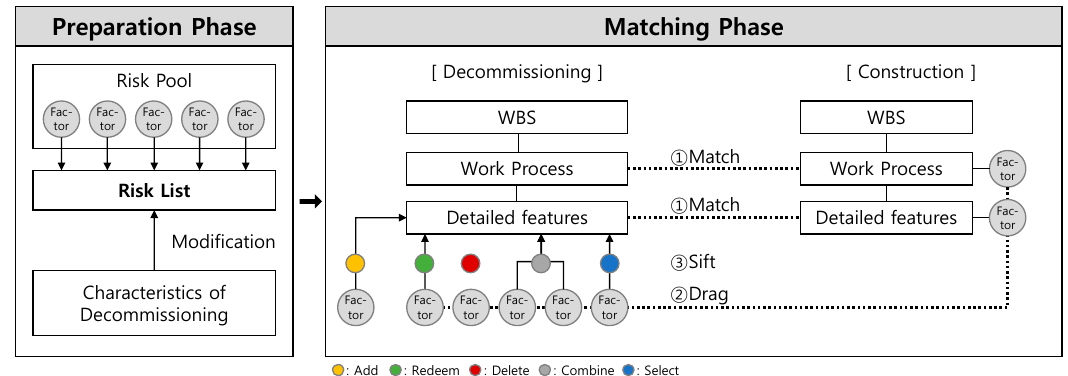
Figure 1. Flow of research methodology.